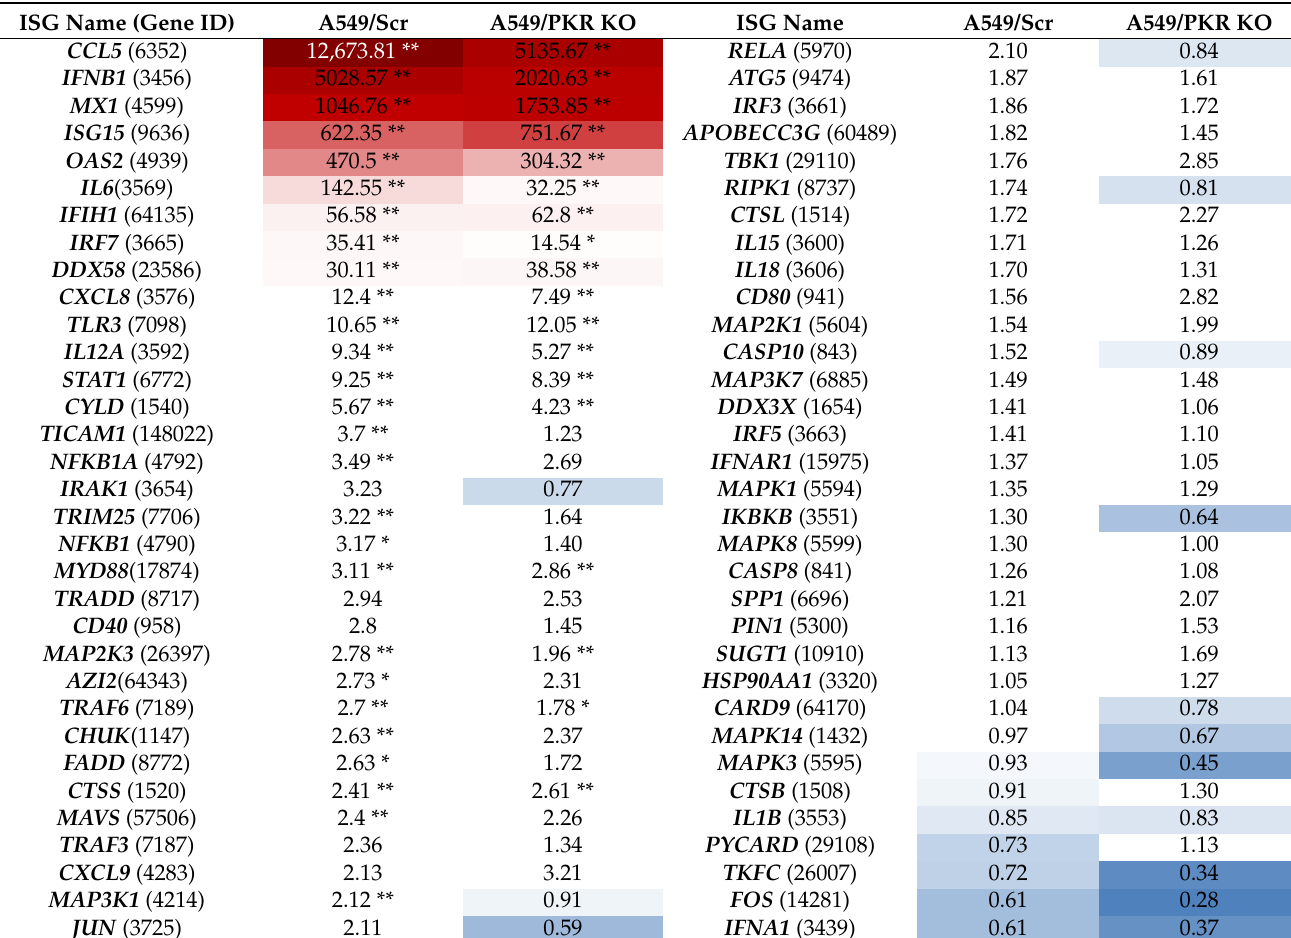
Table 1. ISG profile of A549/Scr and A549/PKR KO cells infected with TCRV. Cells were infected at MOI of 0.01 PFU/cell and collected 5 days after infection. Values correspond to fold-induction (calculated by the 2 − ∆∆ Ct method) and asterisks means statistical significance when compared to uninfected cells (* p < 0.01, ** p < 0.001) in two-way ANOVA test. For clarity, color intensity is proportional to up- or down-regulation (red and blue,